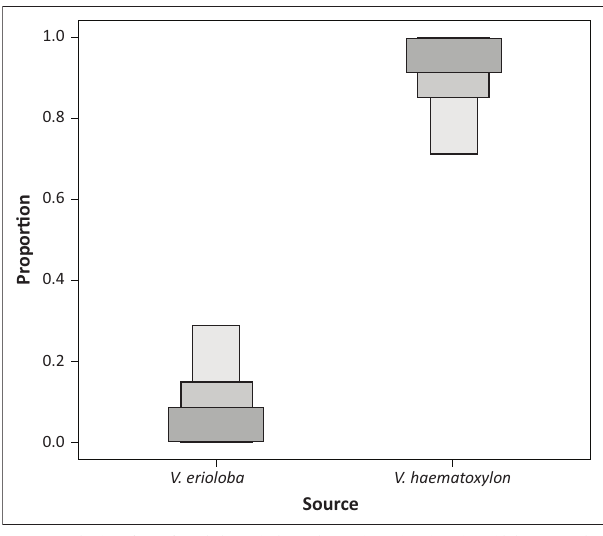
FIGURE 3: The relative proportion of Vachellia erioloba and Vachellia haematoxylon in the diet of giraffe in the Auob River as derived from stable isotope analysis of dung.